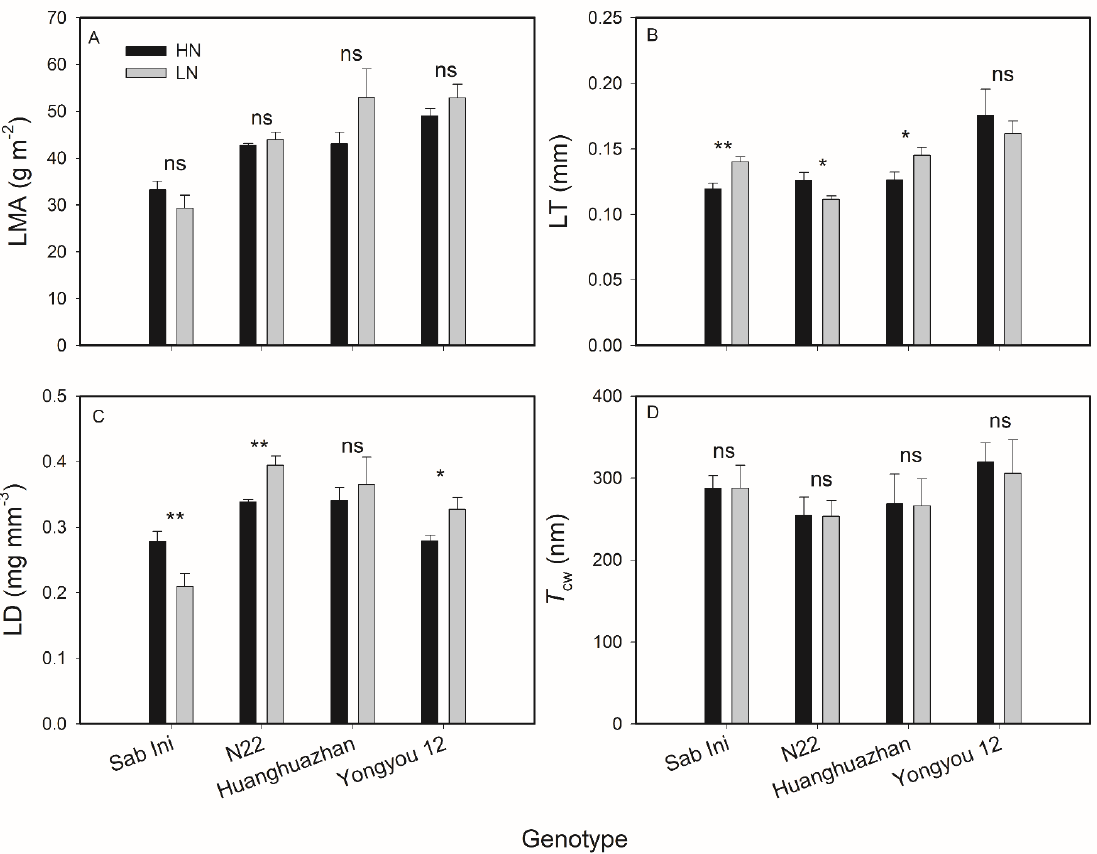
Figure 3. Variations in leaf mass per area (LMA, ( A )), leaf thickness (LT, ( B )), leaf density (LD, ( C )) and cell wall thickness ( T cw , ( D )) in the flag leaves of the four rice genotypes between high (HN) and low (LN) nitrogen supply. Parameters were compared between HN and LN for each genotype based on the least significant difference (LSD) test at the 0.05 probability level. *, p < 0.05; **, p < 0.01; ns, non-significant.